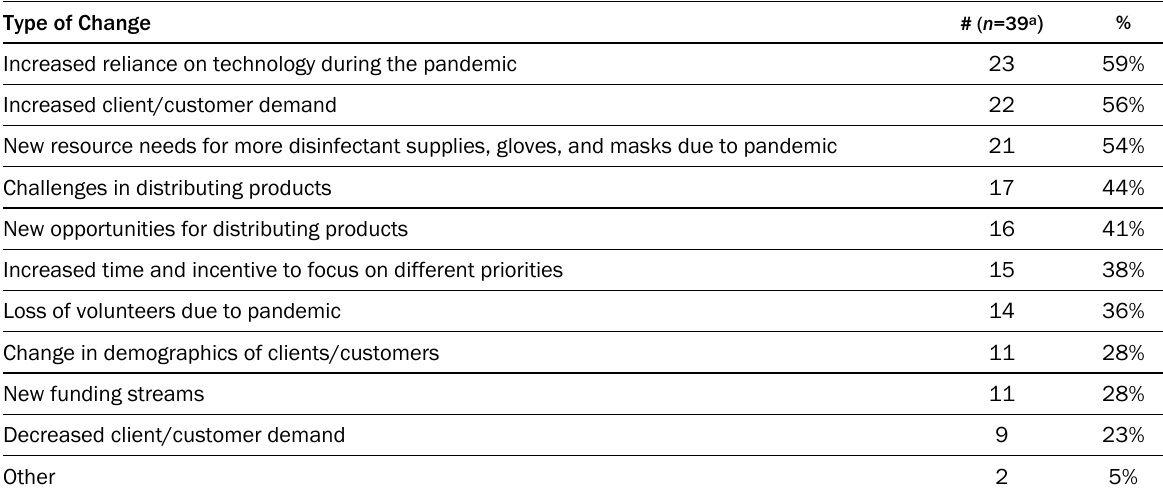
Table 1. Changes Experienced During the Pandemic According to Survey Responses Type of Change Increased reliance on technology during the pandemic Increased client/customer demand New resource needs for more disinfectant supplies, gloves, and masks due to pandemic Challenges in distributing products New opportunities for distributing